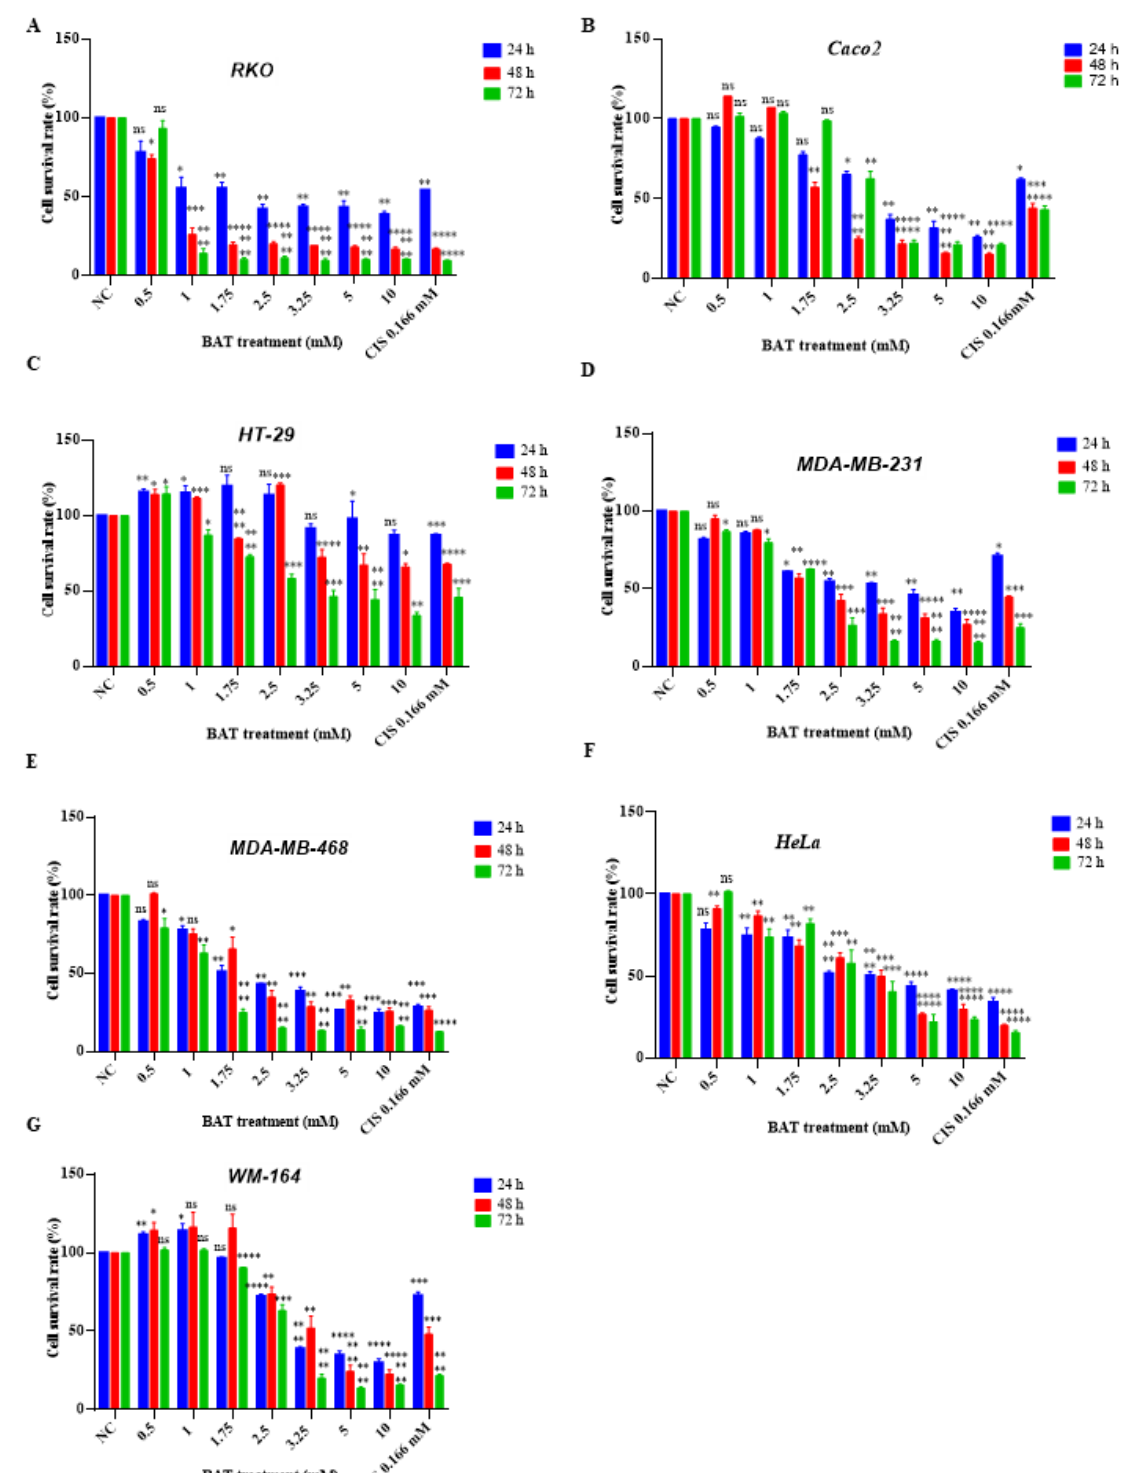
Figure 1. Bromamine T (BAT) is cytotoxic on a wide spectrum of cancer cells. The following cells: ( A ) RKO, ( B ) Caco2, ( C ) HT-29 ( D ) MDA-MB-231, ( E ) MDA-MB-468, ( F ) HeLa, ( G ) WM-164 cells were treated with (0.5–10 mM) BAT or 0.166 mM cisplatin (CIS) for 24–72 h. The percentage of viable cells was assessed upon BAT or Tau treatment versus negative control (NC) using the Crystal Violet procedure and statistical analysis was performed. ns: not significant, * p < 0.05. ** p < 0.01. *** p < 0.001.**** p < 0.0001.